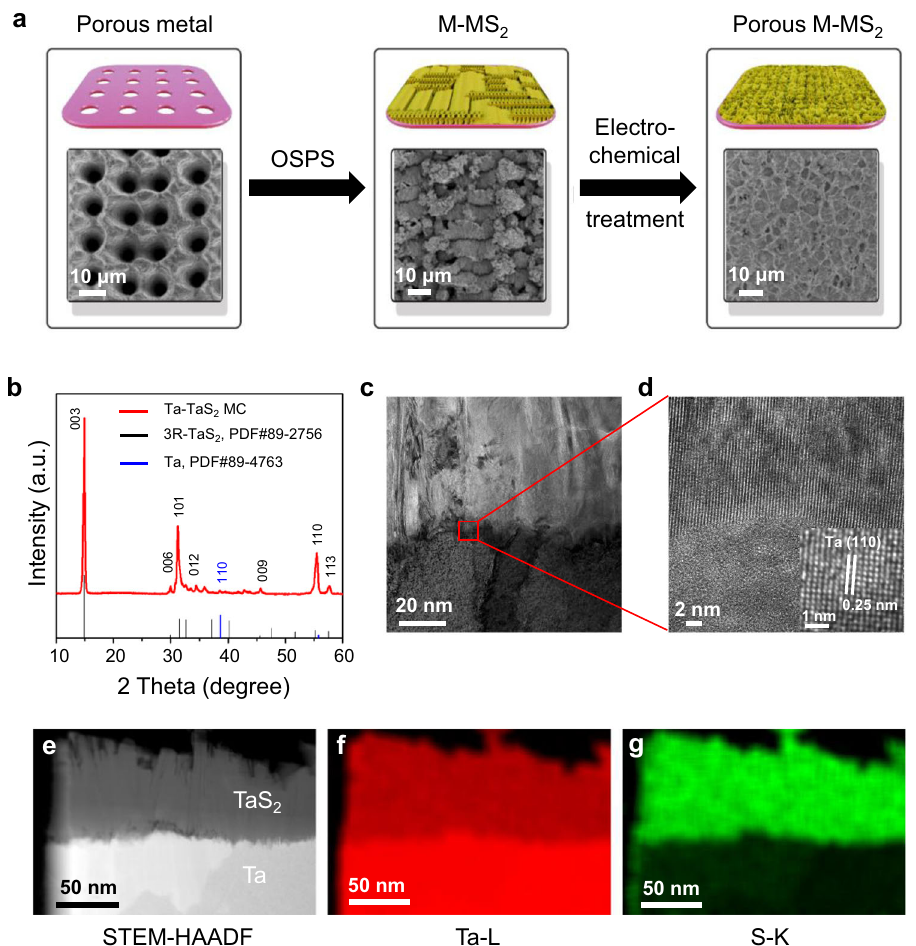
Fig. 2 Synthesis and characterization of the Ta-TaS 2 MC. a The OSPS synthesis process of Ta-TaS 2 MC and corresponding SEM images. b XRD pattern of Ta-TaS 2 MC. c – d TEM cross-sectional image of Ta-TaS 2 MC and a magni fi ed image of the interface. e STEM-HAADF image and ( f , g ) corresponding STEM-EDS elemental maps based on ( f ) the Ta-L peak and ( g ) S-K peak.